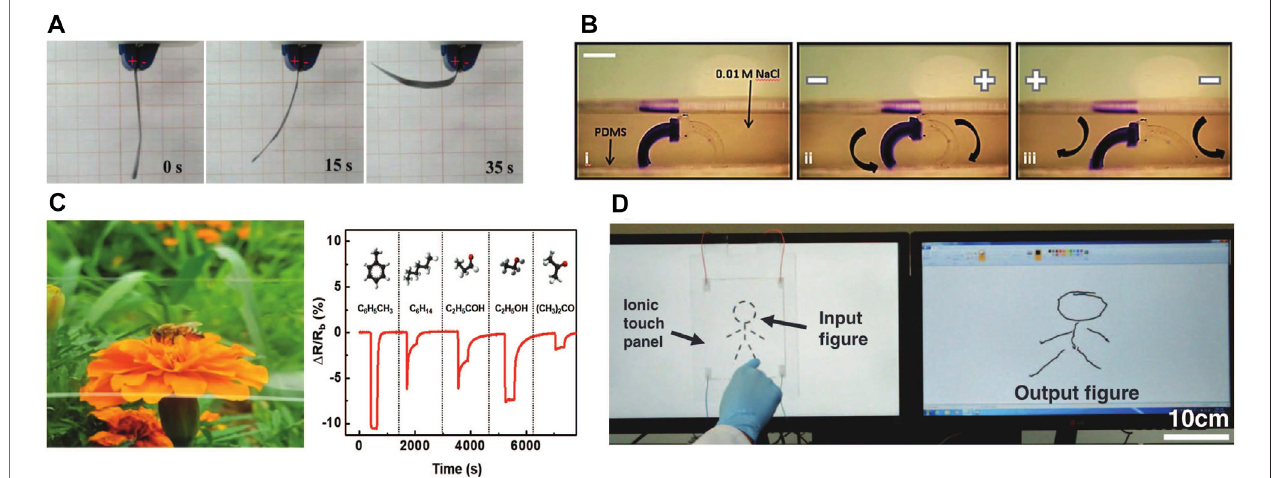
FIGURE4| Examplesofionicsensorsandactuators. (A) AnIPMCbendingunderappliedvoltage.Reproducedfrom[61]withpermissionfromTheRoyalSocietyof Chemistry (B) Electro-actuated hydrogel walkers with dual responsive legs in an electrolyte solution. Reproduced from [62] with permission from The Royal Society of Chemistry (C) A transparent resistance-based chemical sensor of volatile organic chemicals Ⓒ 2018 WILEY-VCH Verlag GmbH and Co. KGaA, Weinheim [63] (D) A transparent capacitor-based touch sensor. Reprinted with permission from AAAS [64].